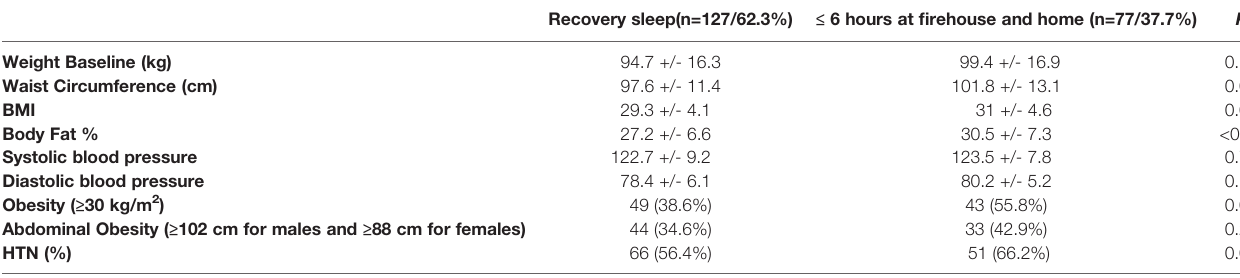
TABLE 4 | Anthropometric measures, obesity and hypertension rates according to reports of post-shift recovery sleep at home.